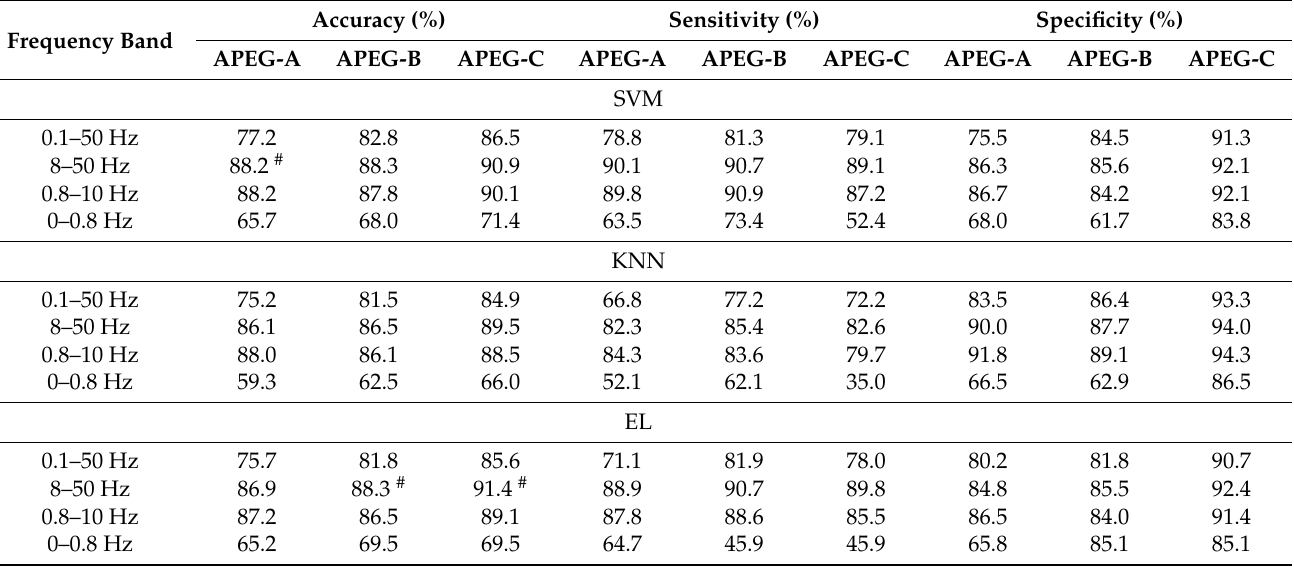
Table 5. Five-fold cross-validation classification performance using a 60 s time window for PAED.